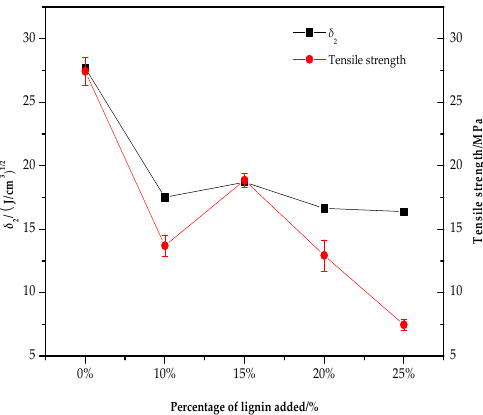
Figure 3. Effect of different proportions of alkali lignin on δ 2 and tensile strength.